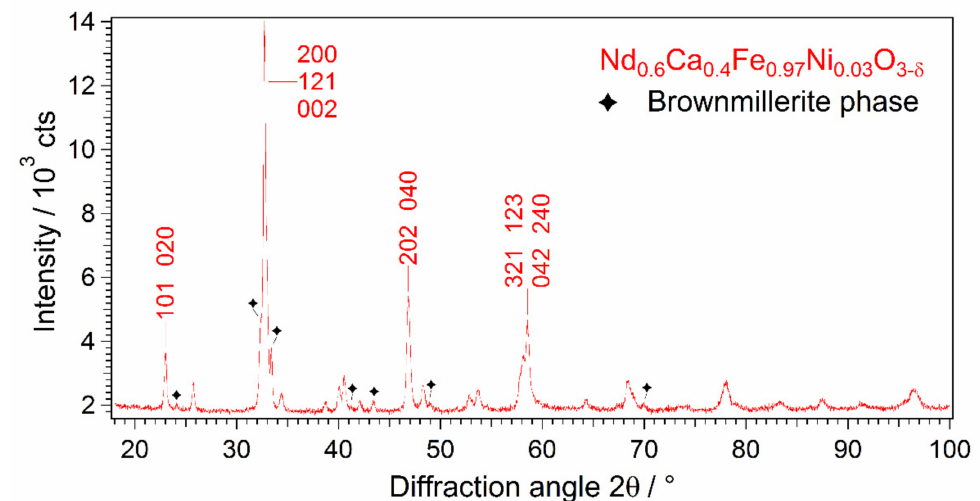
Figure 1. XRD pattern of newly synthesized NdNi. The black stars indicate additional reflexes of an emerging impurity phase—Brownmillerite, Nd x Ca 2-x Fe 2-y Ni y O 5 —which exhibits an ordered vacancy structure. All other reflexes correspond to an orthorhombic perovskite phase (only the main reflexes were indexed for clarity—for a more comprehensive reflex assignment refer to [3]).